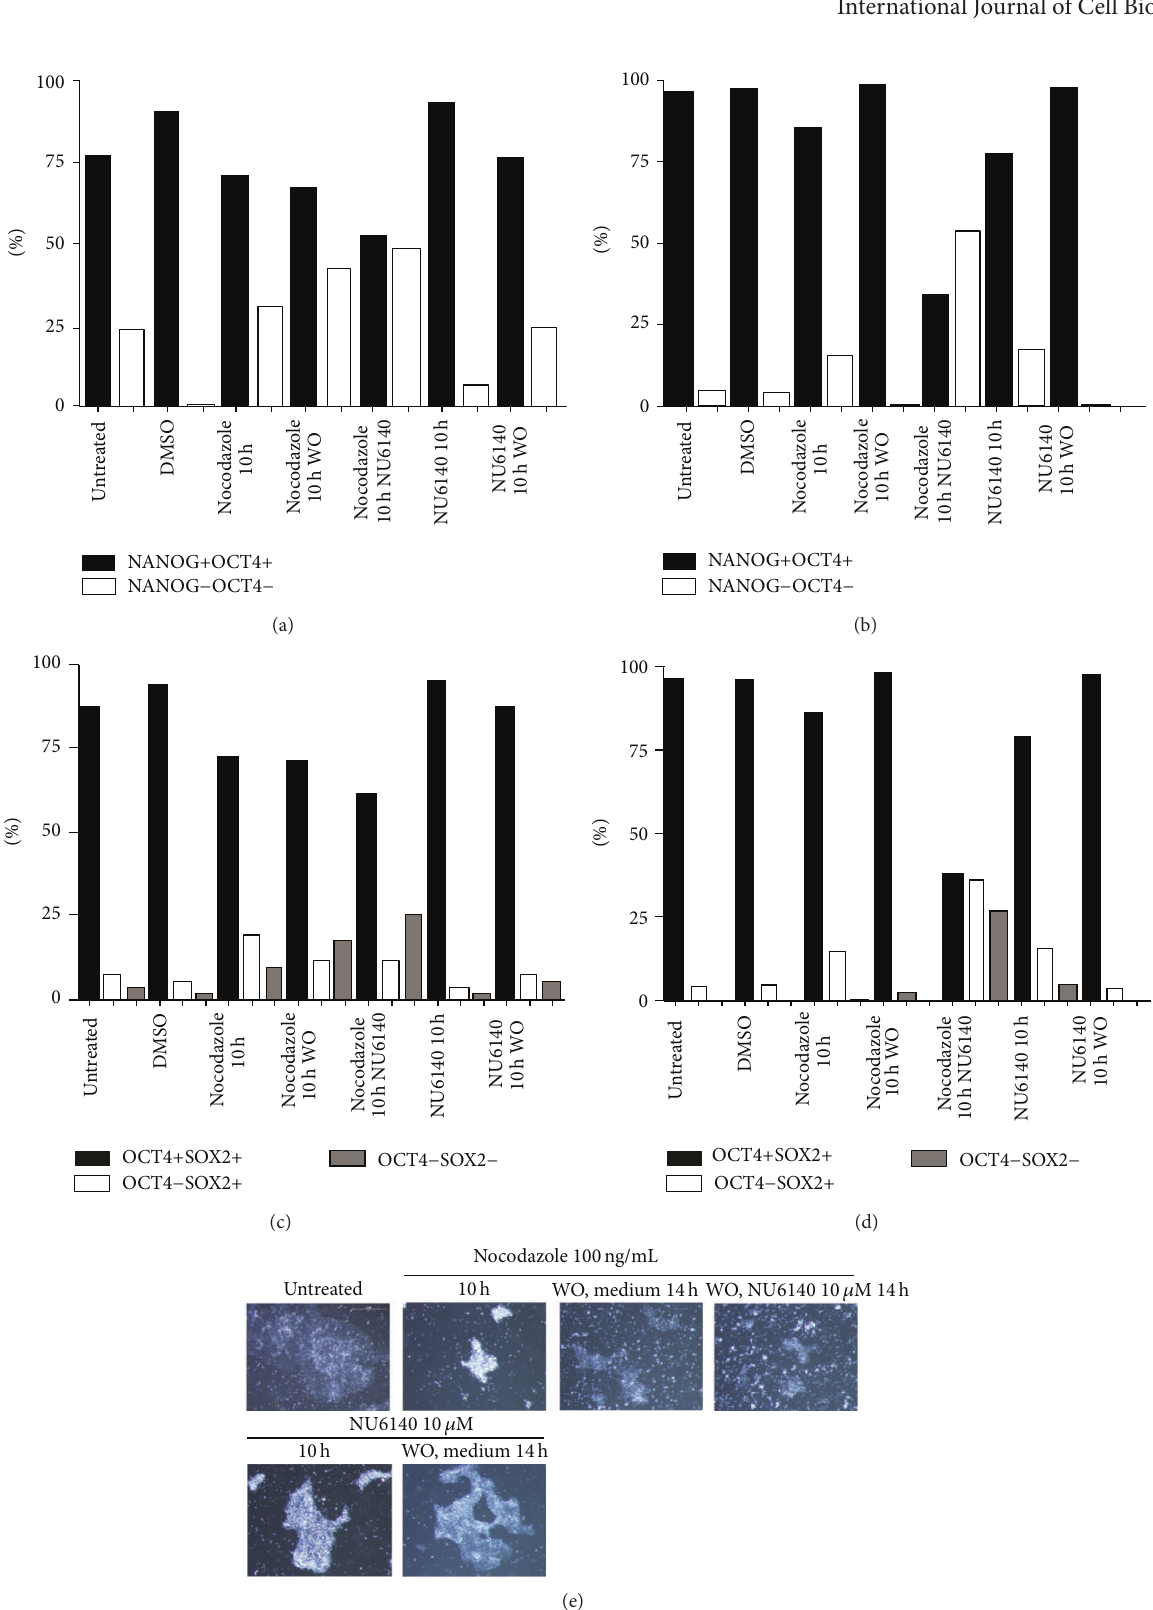
Figure 5: Effect of combined treatment on pluripotency markers expression in hES and hEC cells compared to treatments with nocodazole or NU6140 individually. Nocodazole treated cells (10h) were washed and further treated with 10 𝜇 M NU6140 for 14h. The coexpression of NANOG/OCT4 and SOX2/OCT4 detected in hEC (a, c) as described in Figure 2 and in hES cells (b, d) as described in Figure 1. (e) Morphological changes in colony structure of hES cells treated with NU6140 or